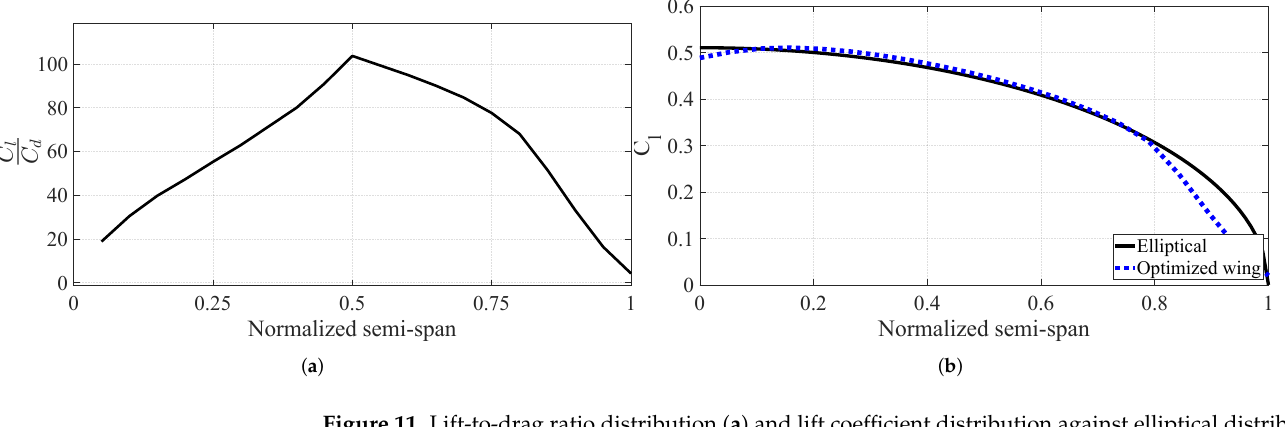
Figure 11. Lift-to-drag ratio distribution ( a ) and lift coefficient distribution against elliptical distribu- tion ( b